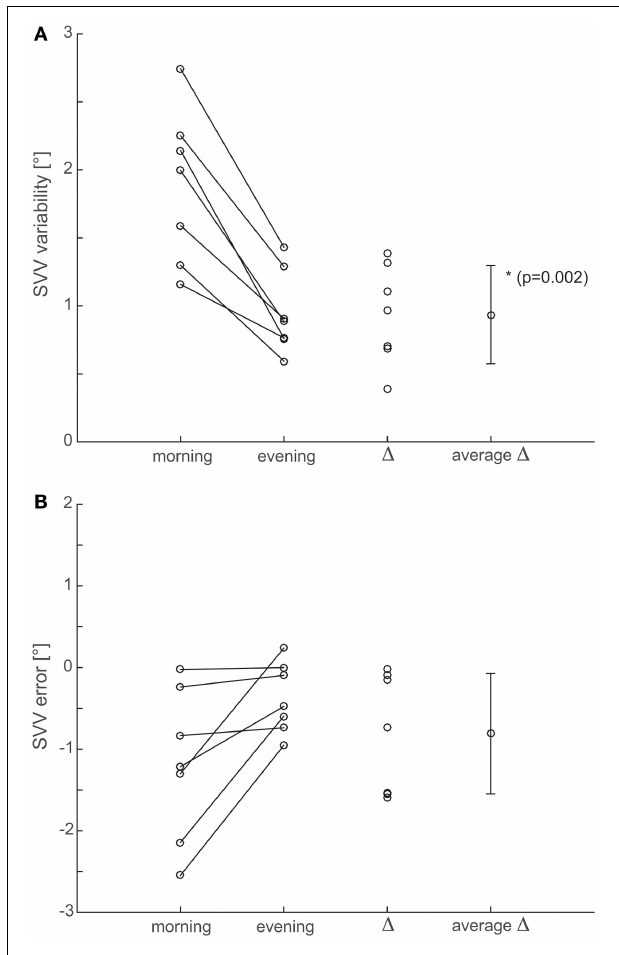
FIGURE 4 | Summary of both precision (A) and accuracy (B) of SVV adjustments . To improve statistical power, data points from all seven recording sessions were pooled after confirming that there were no statistically significant ( p > 0.05) differences between single sessions. For both precision (i.e., trial-to-trial variability) and accuracy (i.e., adjustment errors), individual average values from recordings in the morning (first column from left) and in the evening (second column from left) are compared for all seven subjects. Furthermore, individual differences ( ∆ , third row) and average ( (cid:6) 1SD) differences (average ∆ , fourth row from left) are